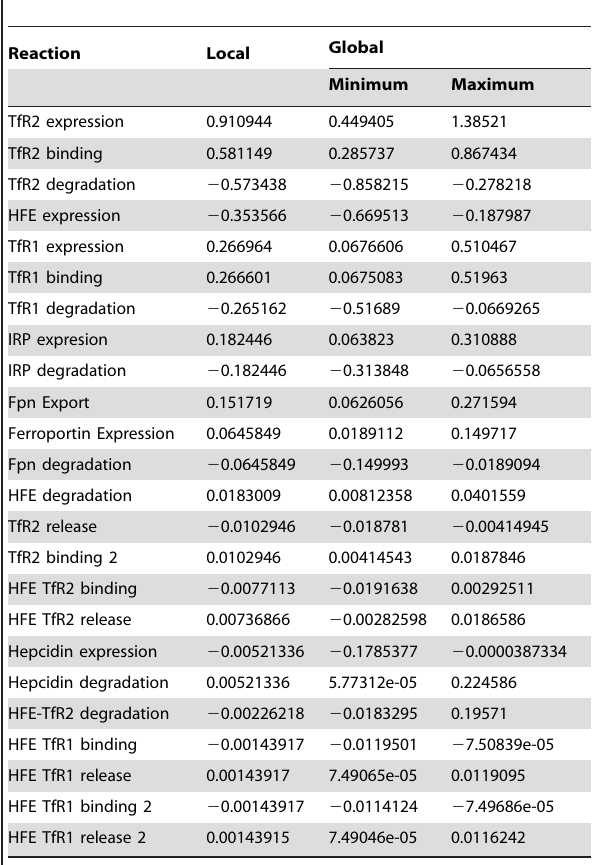
Table 7. Metabolic control analysis—Flux-control coefficients for the iron export out of the liver